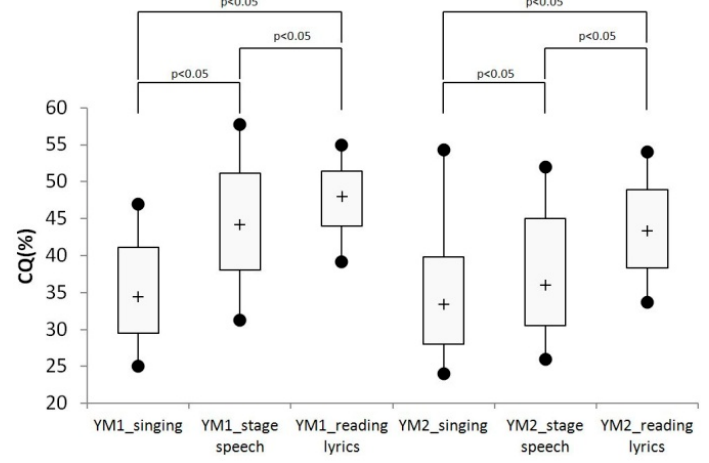
Figure 3. Box plot of CQ.